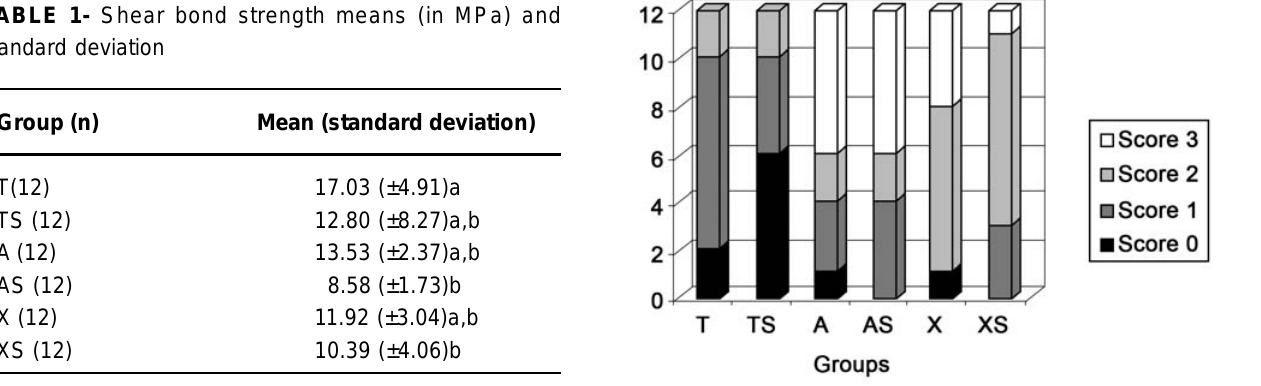
Different letters indicate statistically significant difference